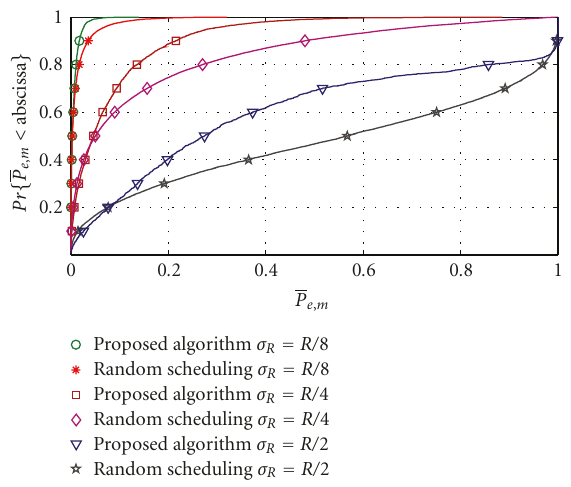
Figure 6: CDF of P e , m for all nodes in all networks.